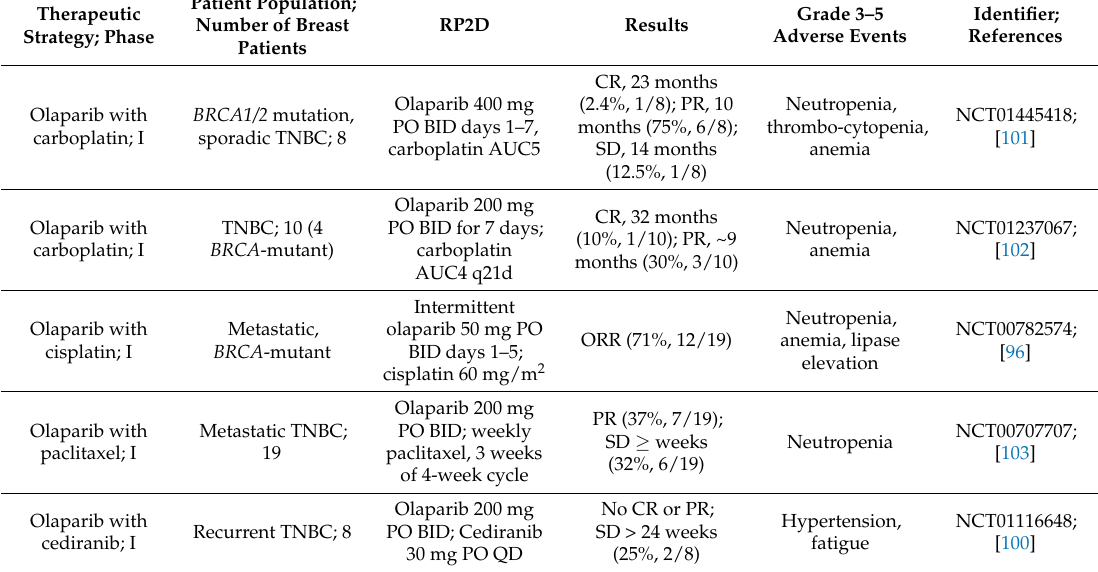
Table 1. Completed clinical trials with olaparib combination in breast cancer patients. (AUC = area under the curve; BID = bis in die, twice a day; CBR = clinical benefit rate; CR = complete response; ORR = objective response rate; PO = per os, by mouth; PR = partial response; QD = quaque die, once a day; RP2D = recommended phase 2 dose; SD = stable disease; TNBC = triple negative breast